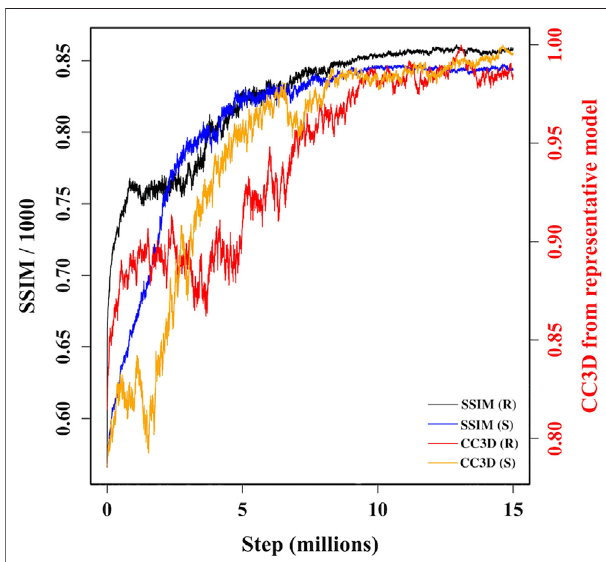
FIGURE 3 | A plot of variation of similarities between candidate models along two MC trajectories, initiated from R and S models, and target AFM image 7. The left vertical axis shows variation of SSIM between candidate models and target AFM image. The right vertical axis shows variation of the correlation coef fi cient after rigid-body fi tting of kernel centers between intermediate candidate models and fi nal converged